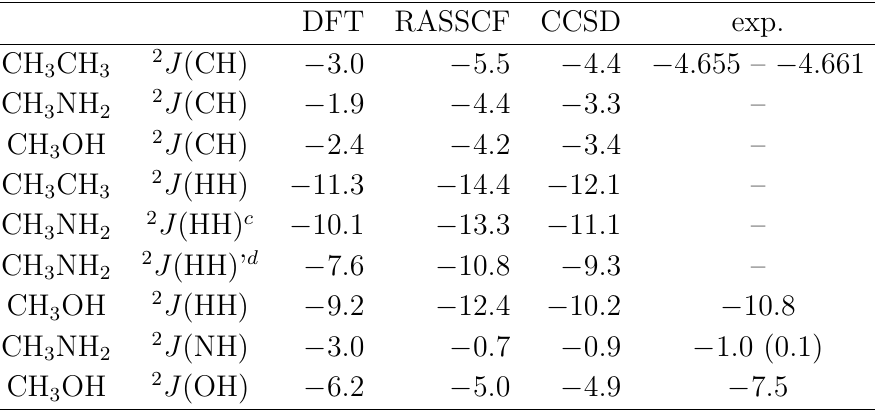
Table 3: Comparison of the total geminal coupling constants calculated at the DFT, RASSCF a and CCSD levels with experiment.